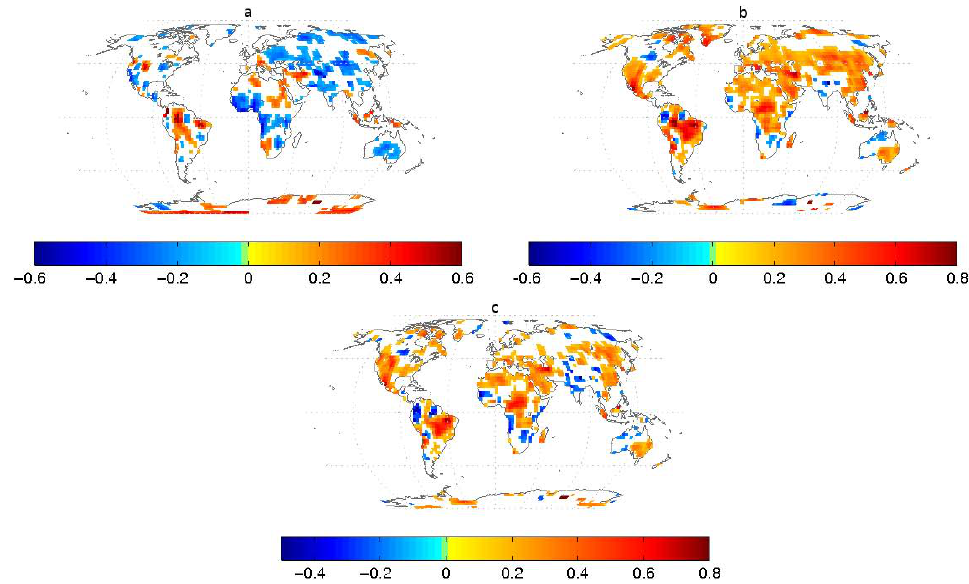
Fig. 7. Statistically significant (95% confidence interval) trends of the normalised anomaly of (top left) wind speed U , (top right) VPD e s − e , and (bottom) bulk aerodynamic evaporation E a . All three time series are blended from ERA-40 and Interim, at each 2.5 ◦ × 2.5 ◦ cell. Units are decade − 1 . Table 2. Global, NH and SH decadal trends for the original timeseries of potential evaporation over land areas and other relevant physical quantities. The period of reference is July 1983–June 2008 for Q s , Q l , and E r . For U , e s − e , E a , and E p , periods of reference are July 1983–June 2002 (ERA-40) and January 1989–December 2007 (ERA Interim), i.e. complete years in both cases. The units of each trend are the units of the relevant quantity divided by